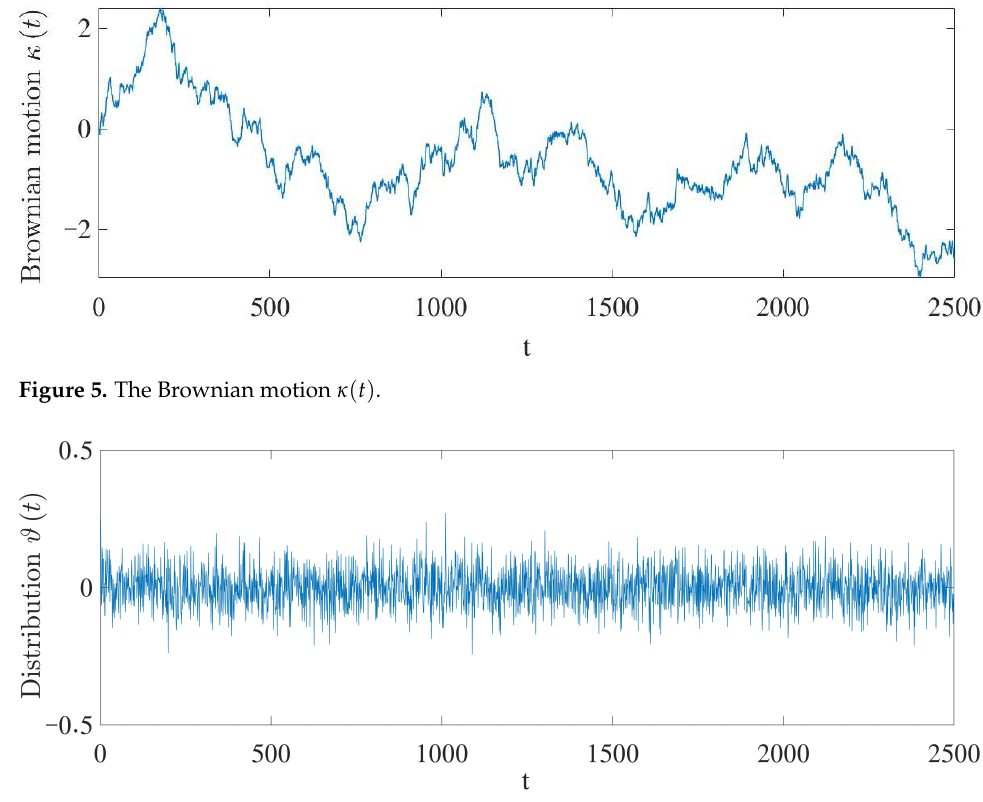
Figure 6. The distribution ϑ ( t ) of Brownian motion κ ( t )